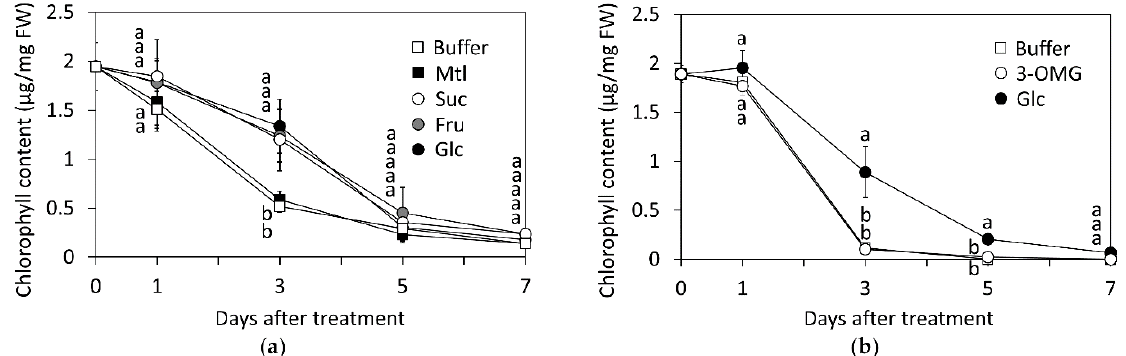
Figure 2. Effects of sugars on GR24-induced reduction in chlorophyll content in leaf segments of rice d10 mutant. Leaf segments were treated with 1 µ M GR24 and 1% sugars at 25 ◦ C in dark. The control (Cont) was treated without sugars. ( a ) Total chlorophyll content in 1 µ M GR24-treated leaves with mannitol (Mtl), sucrose (Suc), fructose (Fru), and glucose (Glc) treatment. ( b ) Total chlorophyll content in GR24-treated leaves with 3-O-methyl glucose- (3-OMG) treatment. Values and bars show means ± SD ( n = 3). Letters show a significant difference ( p < 0.05) as determined by Tukey’s HSD test at the same time point.